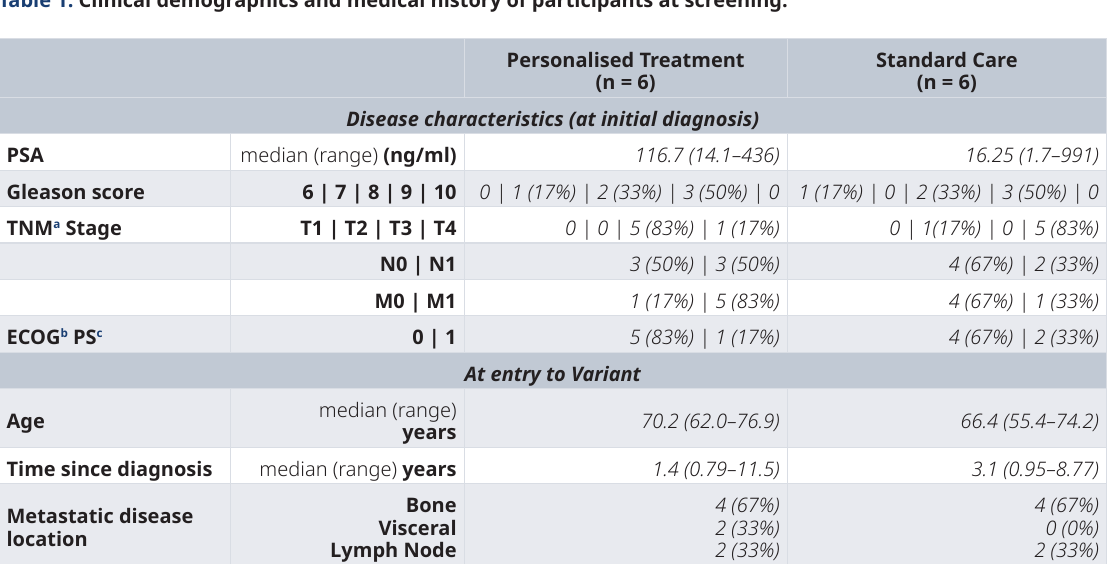
Table 1. Clinical demographics and medical history of participants at